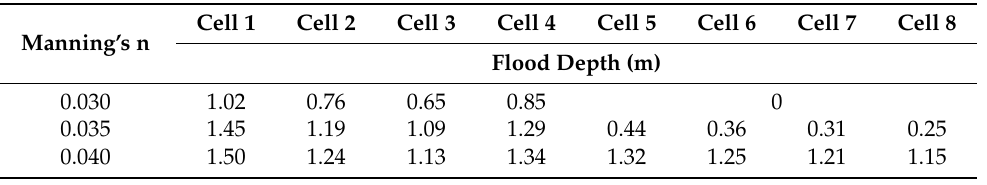
Table 4. Maximum flood depth values in different cells for certain cross sections in sub-reach K6 (varying Manning’s n value).